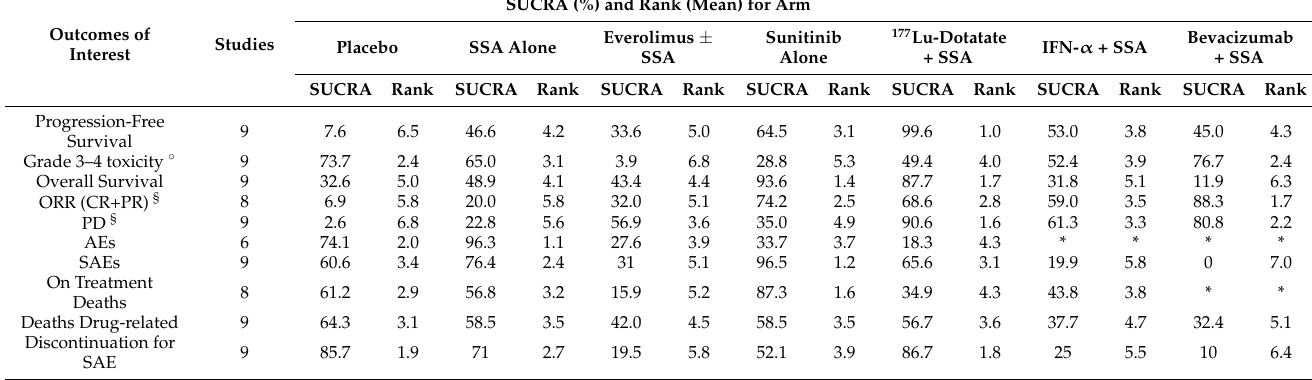
Table 3. The surface under cumulative ranking area (SUCRA) values and mean rank for all outcomes. The SUCRA values express, in percentages, the safety or efficacy of each approach relative to an imaginary approach, which is always best without